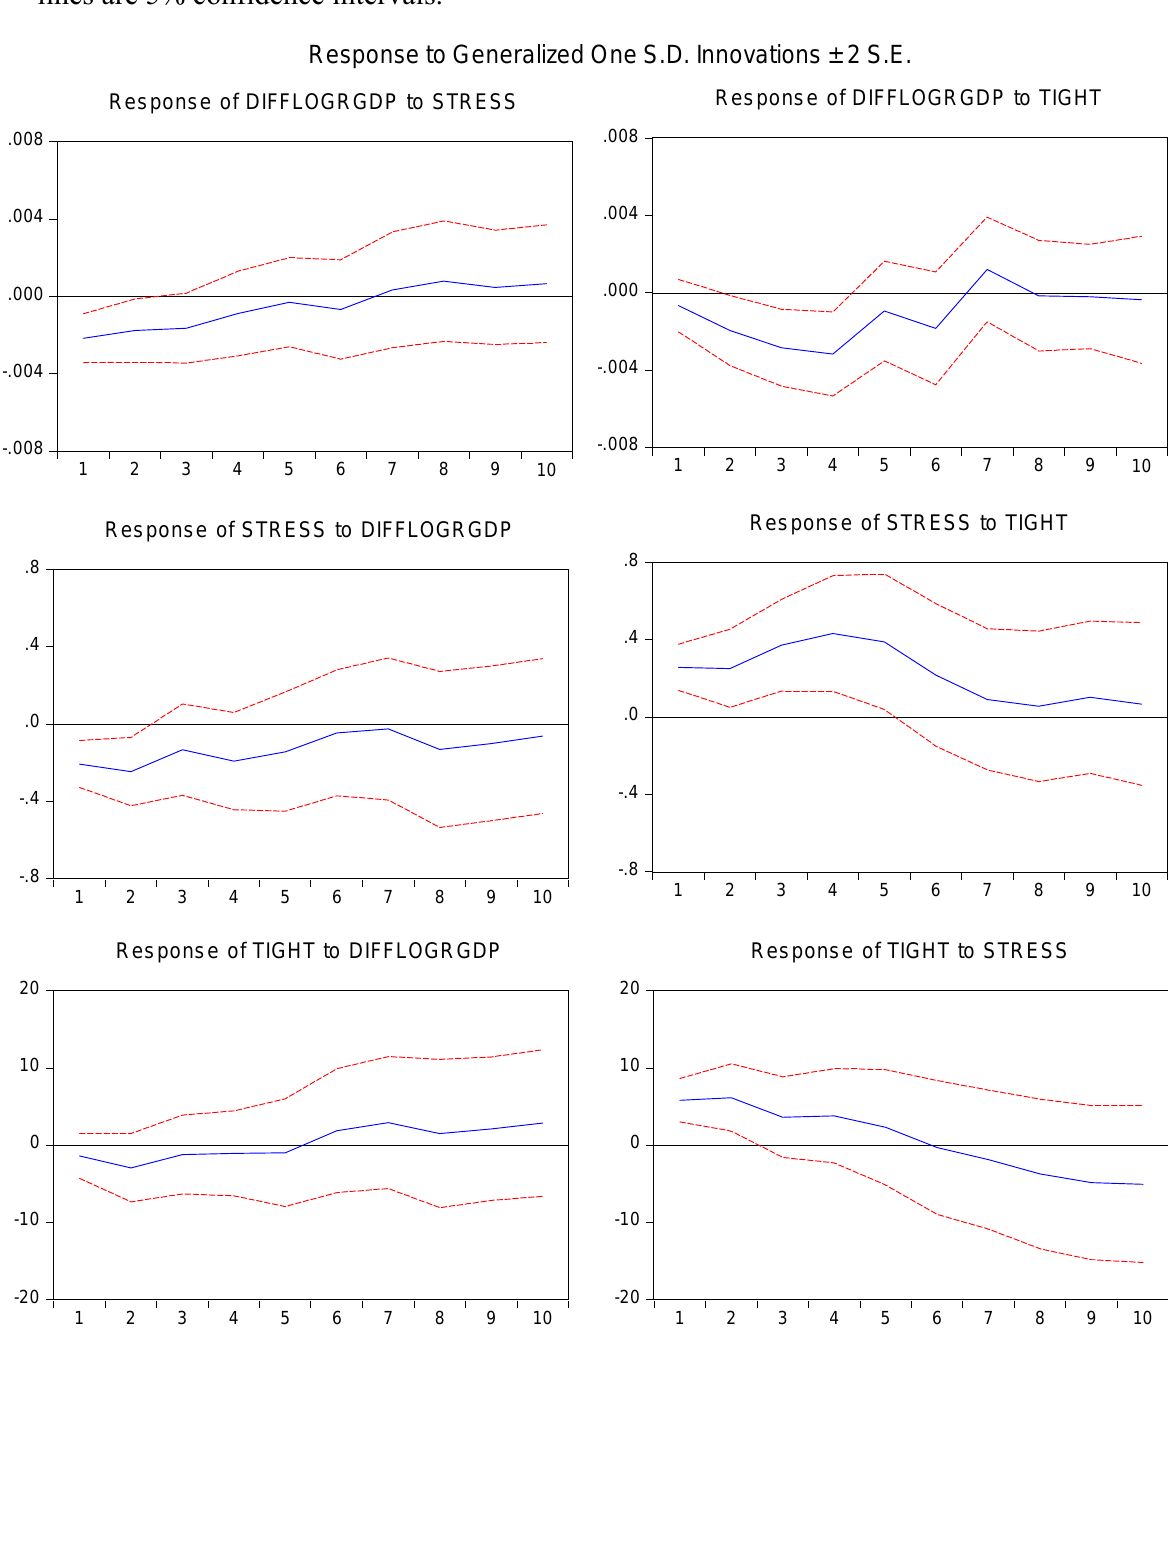
Figure 5. Impulse response functions for the three variable VAR with seven lags. The red lines are 5% confidence